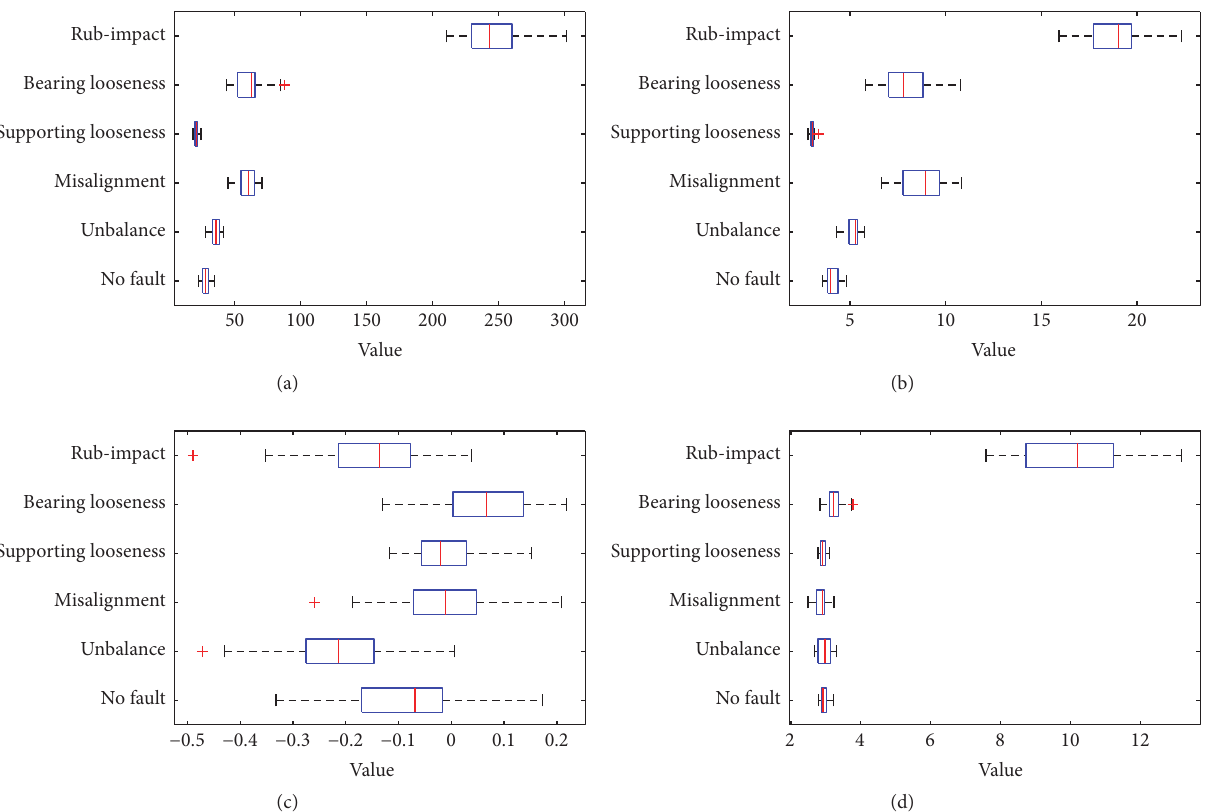
Figure 7: Boxplot of peak-to-peak value (a), root-mean-square (b), skewness (c), and kurtosis